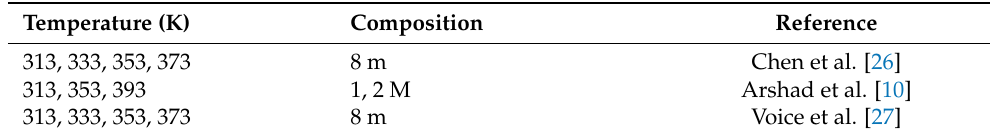
Table 1. Literature studies reporting experimental data for the CO 2 solubility in aqueous MAPA solutions.